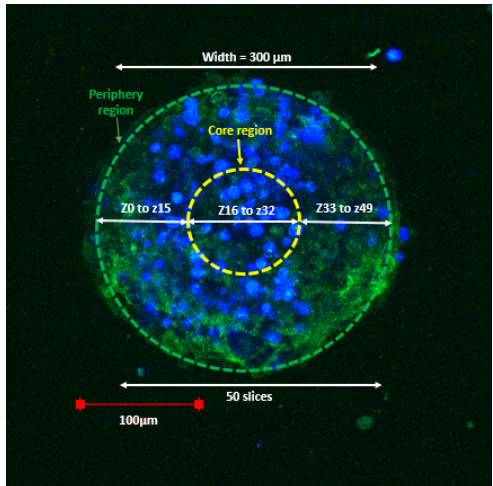
Figure 2. Partitioning of in vitro 3D cell spheroid into